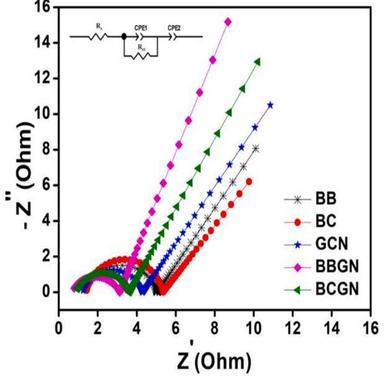
Nyquist plots of BB, BC, GCN, BBGN and BCGN with the equivalent circuit model.